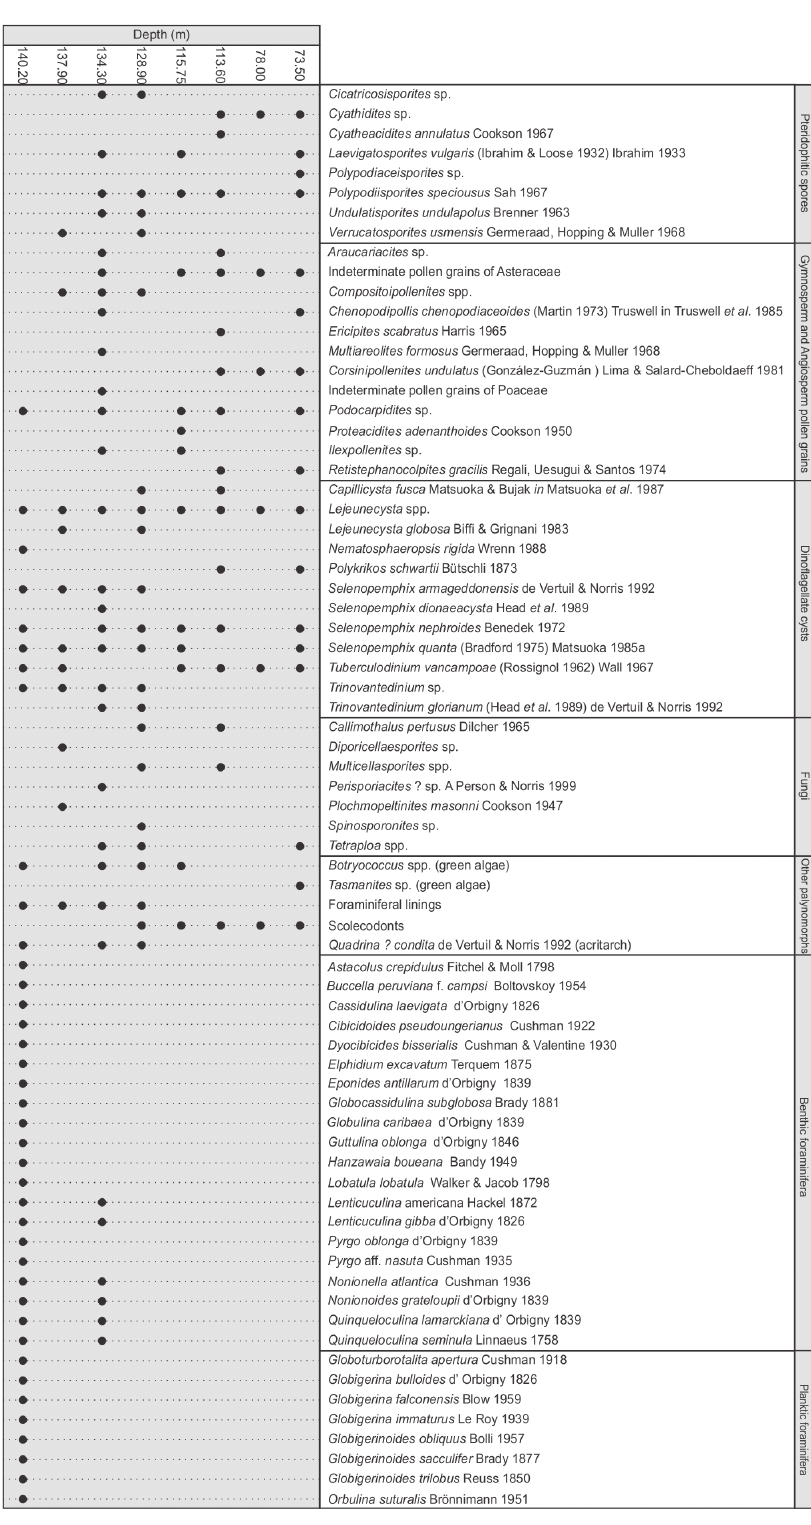
Fig. 2 - Stratigraphic distribution of the micropaleontological content (palynomorphs and foraminifera) in well